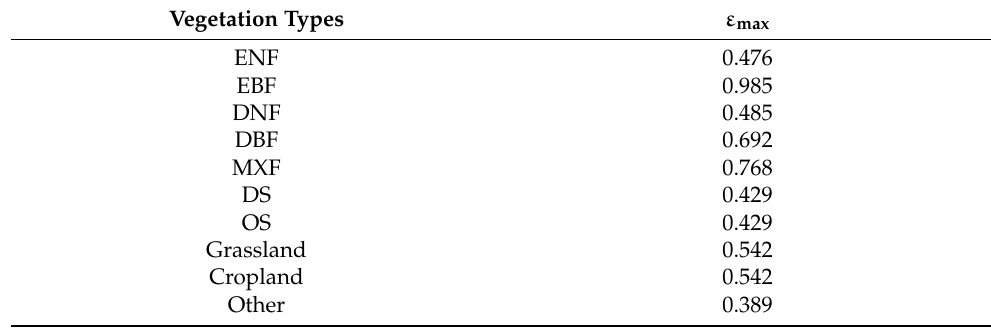
Table 2. Maximum light energy utilization ( ε max ) of typical vegetation types in China (gC · MJ − 1